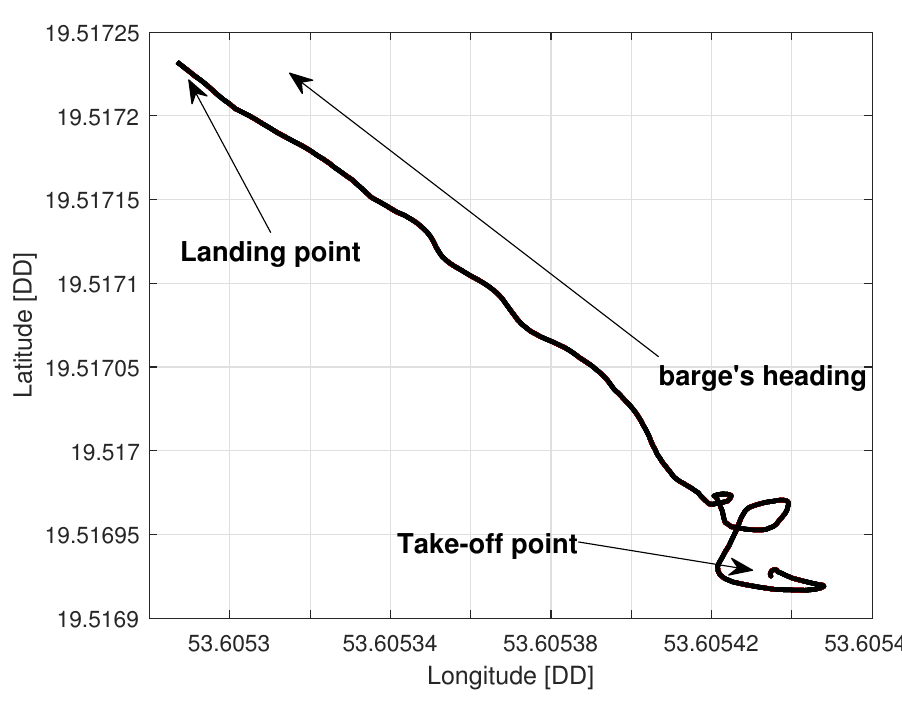
Figure 15. VTOL path during the in-flight test.